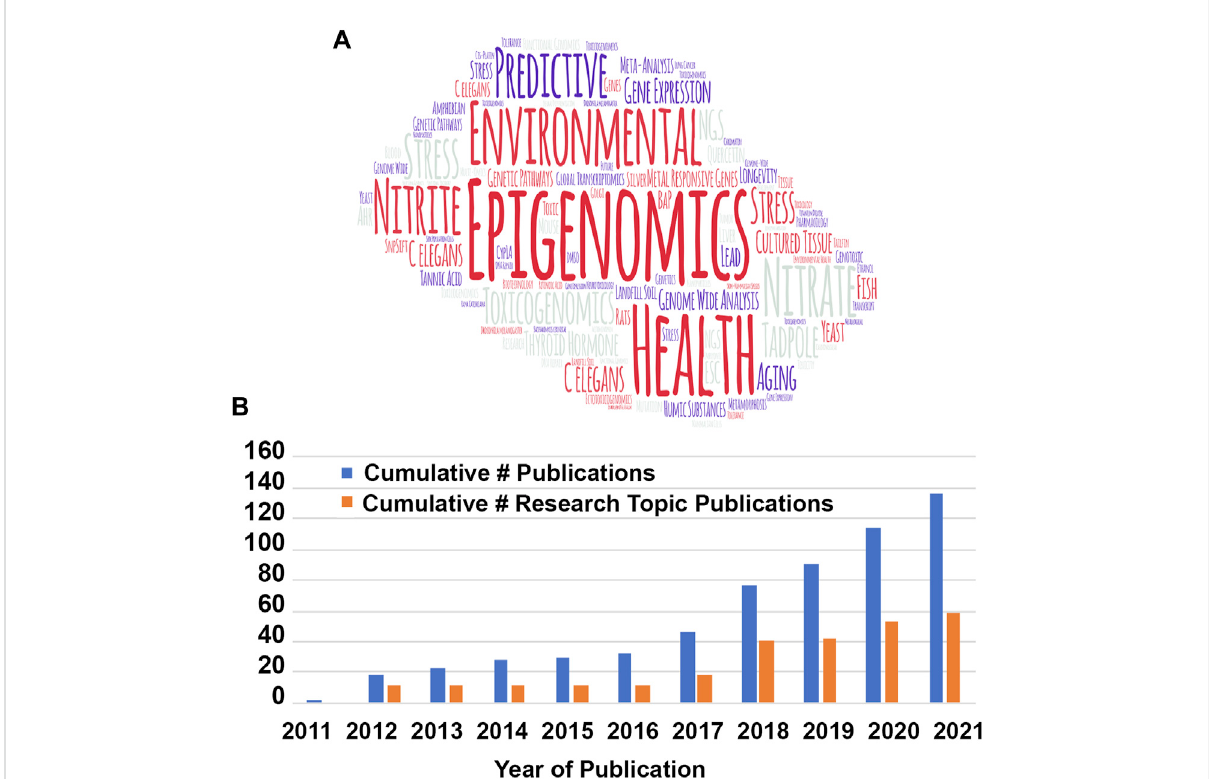
FIGURE 1 Cumulativenumberofpublicationsandresearchtopicpublications. (A) Wordcloudoftitlesfromthe fi rst25ofthe138publicationspublishedin the fi rst 10 years of Frontiers in Toxicogenomics/Toxicology. The size of the word is proportional to the frequency that word is used in the titles ( fi gure made from http://wordart.com). (B) . Cumulative number of publications (all – blue; research topic – orange). Note that research topics currently include over half of the submitted